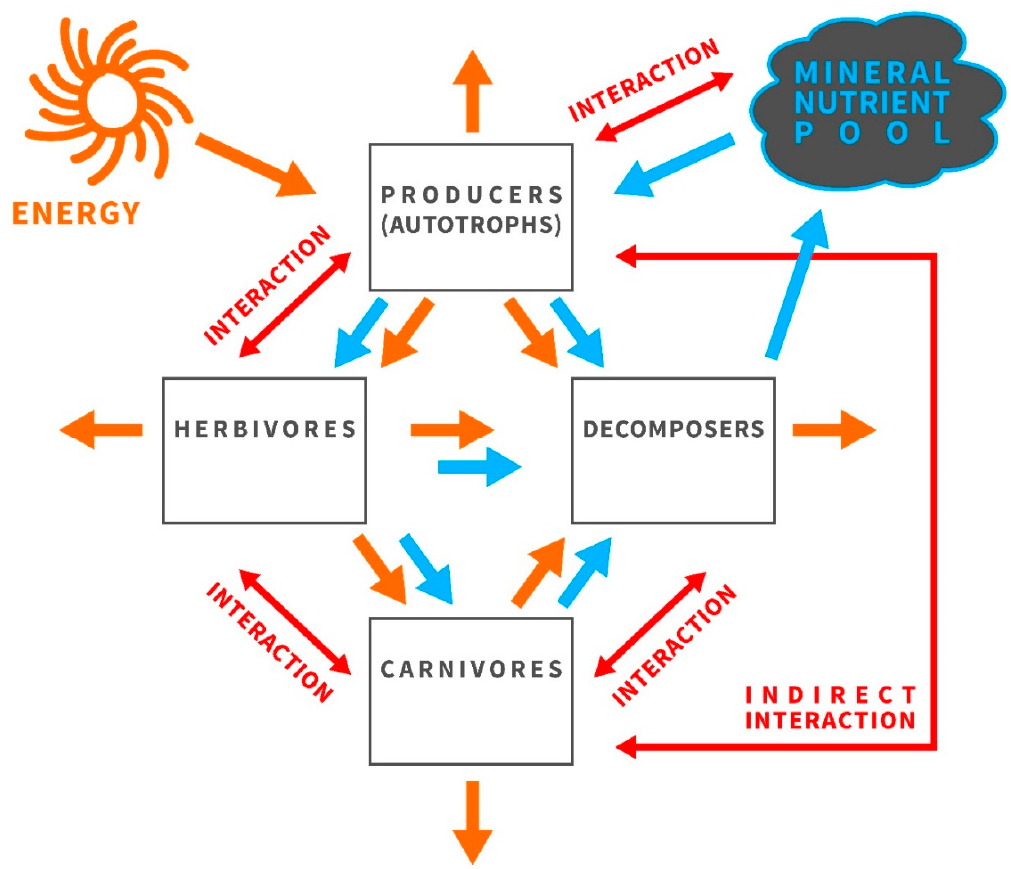
Figure 2. Organisms in an ecosystem interact with each other and with the abiotic world to grow, develop, produce progeny, and maximize fitness. Energy, shown in orange, is flowing through the ecosystem while the mineral pool (in blue) is cycling, and consumers are drivers of this cycle. Only a given pool of nutritional supply is available, and interactions between components of this food web (in red) are shaped by food quality, which is crucial for consumer growth and population dynamics. The study of the balance of energy and matter in ecological interactions is called ecological stoichiometry. This research framework capitalizes on the fact that organisms are composed of identical building blocks—atoms of chemical elements—even though they build remarkably diverse organic molecules. Within this context, it is possible to focus on a single interaction within this web.